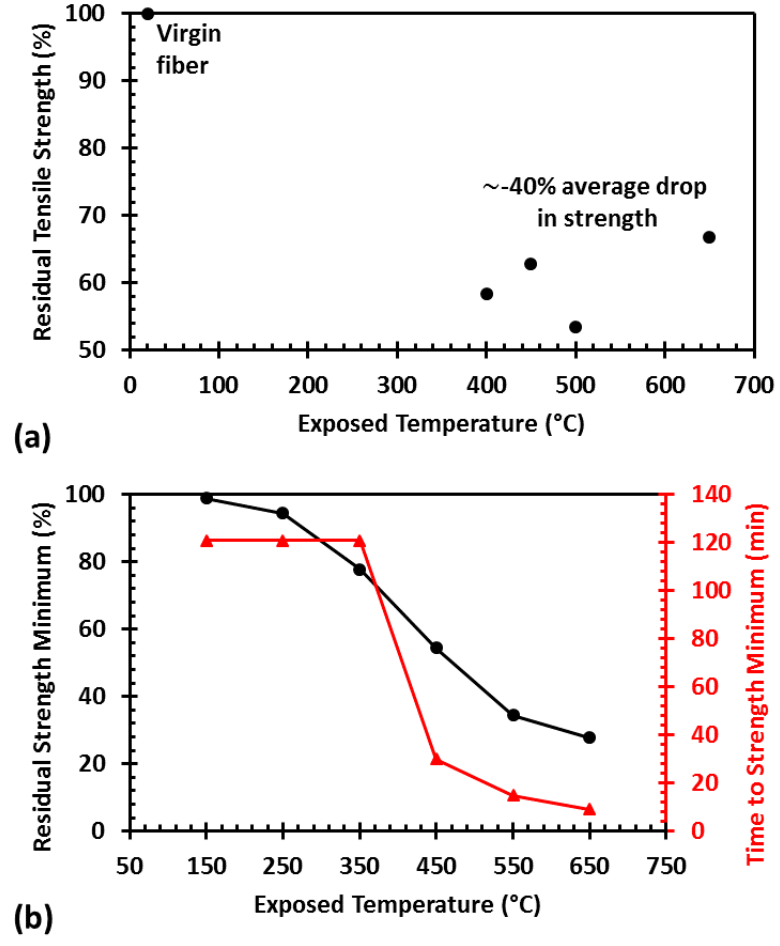
Figure 1. ( a ) Average single filament tensile strength results from pyrolyzed thermoset polyester SMC with calcium carbonate and aluminum trihydrate fillers. Redrawn from data in Cunliffe et al. Tables 8 and 9 in [7]. ( b ) Minimum residual tensile strengths achieved in E-glass fiber at various pyrolysis temperatures (black circles) versus measured upper bound time limit for reaching said minimum (red triangles). Redrawn from data in Feih et al. Figure 1(a) in